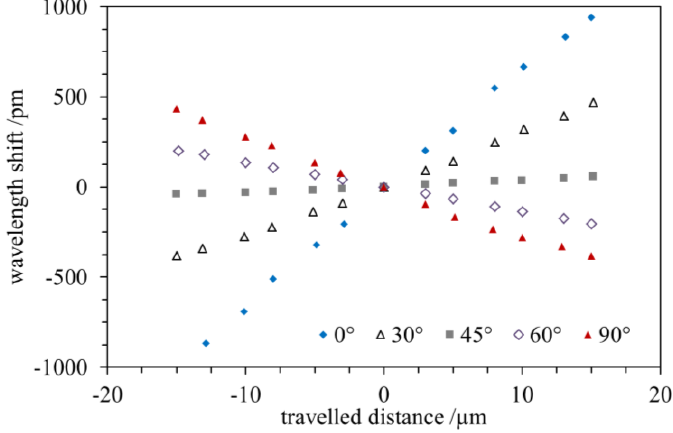
Figure 3. Spectral shift of the Bragg wavelength vs. travel distance for different orientations between the waveguide and the direction of the load transmission. The sensitivity of the PPBG sensor is highest for parallel orientation (0°) and almost vanishes at an angle of